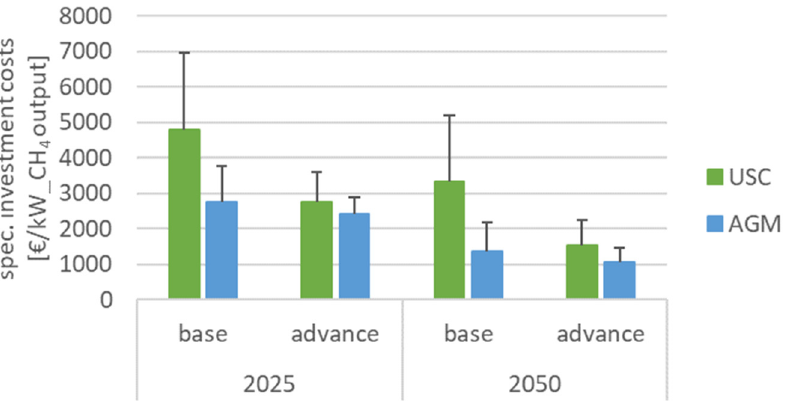
Figure 5. Specific investment costs of USC plants related to the process configuration (base and advance) and year of installation and additionally the costs for an Above Ground (catalytic) Methanation (AGM) with comparable SNG production. (A plant with a nominal volume flow of 100,000 Nm 3 /h is given as a reference. The upper value of the error indicator indicates the costs for a 25,000 Nm 3 /h